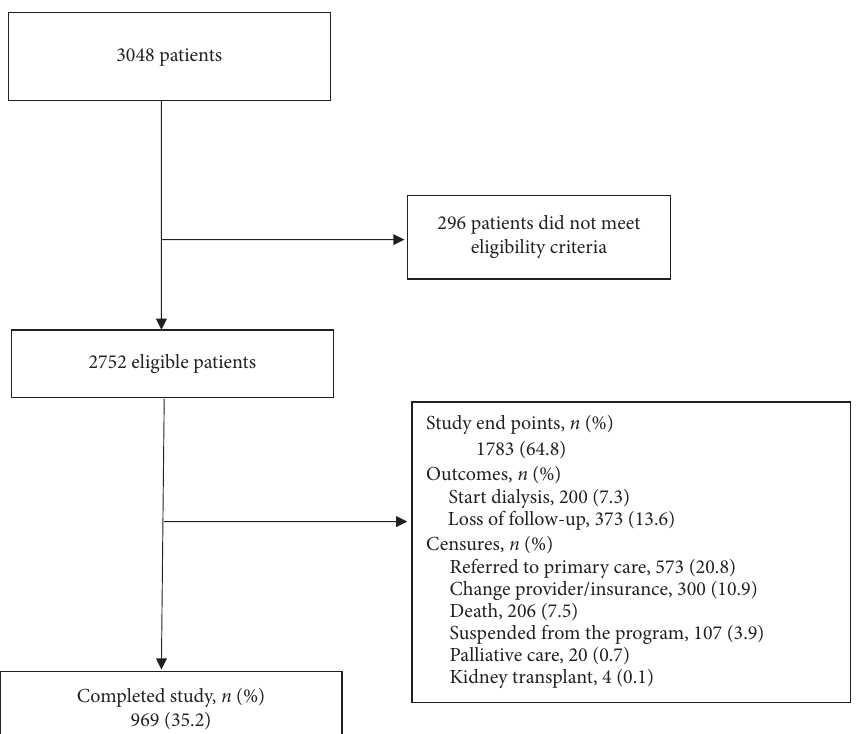
Figure 1: Flow chart of patients in the study. The diagram shows the flow of patients in the study. Of the 3048 originally recruited patients, 296 did not meet the eligibility criteria. 969 patients finished the study without presenting an outcome or censure events.